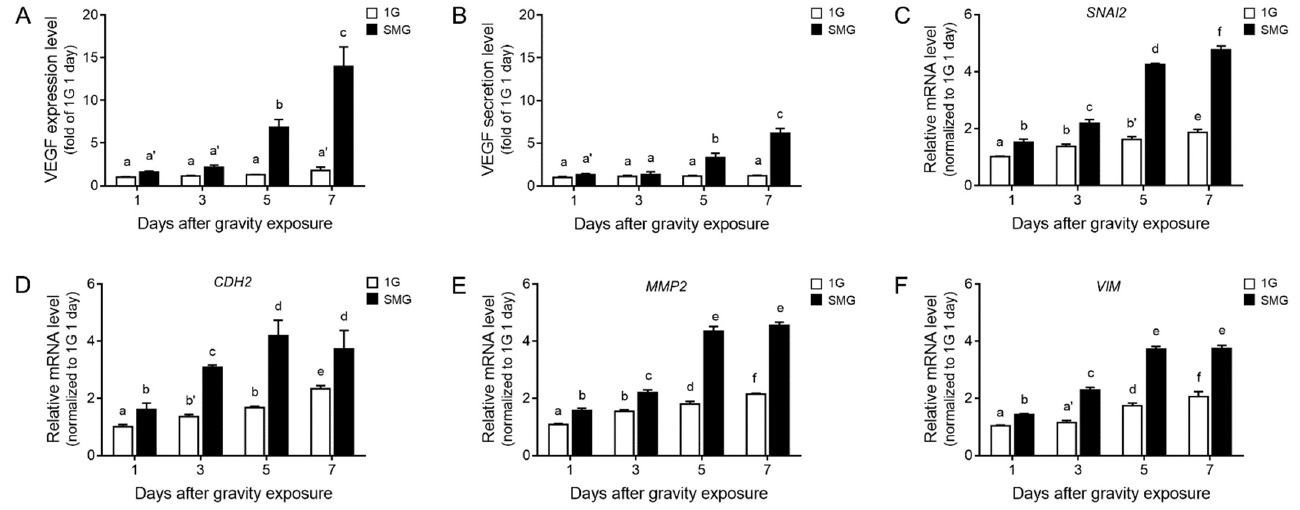
Figure 2. Increased VEGF level and EMT marker expression in microgravity-stimulated ARPE19